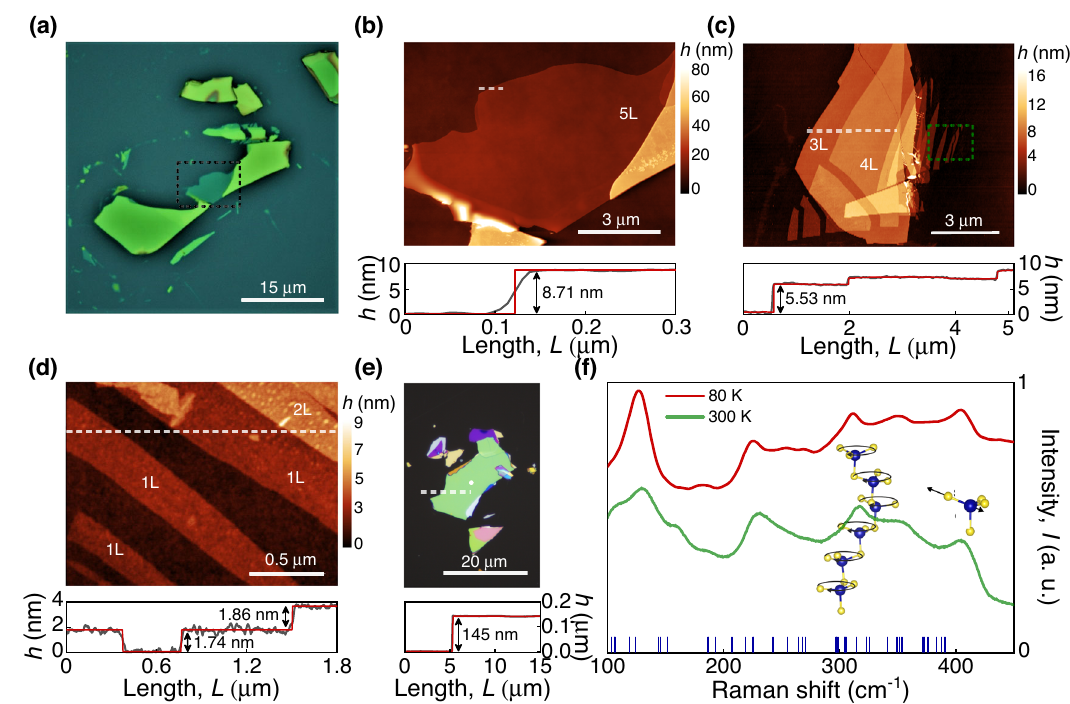
Fig. 2 Cleavage feasibility of non-van der Waals InGaS 3 . a 100X optical micrograph of a typical nanosheet on Si/SiO 2 substrate. b AFM topographical scan over the region marked by dashed rectangle in panel ( a ). Height pro fi le is taken along the dashed line in the map, showing the thickness equivalent to 5 L (8.71 ± 0.38 nm). c Same as in panel ( b ), but for thinner atomic sheets, with a thickness equivalent to 3 L (5.53 ± 0.32 nm) and 4 L (7.3 ± 0.34 nm). d Same as in panel ( c ), but for a magni fi ed region marked by the dashed rectangle in panel ( c ) showing atomic strips with thicknesses equivalent to 1 L (1.74 ± 0.24 nm) and 2 L (1.74 + 1.86 ± 0.28 nm). e 100X optical micrograph of a typical nanosheet on a quartz substrate. White dot marks the Raman spectra collection point (145 ± 4 nm). f Raman spectra of the nanosheet presented in panel ( e ) at room (green line) and liquid nitrogen (red line) temperatures. Vertical bars label evaluated Raman-active modes (see Supplementary Table 3 for details). Insets: Schematic representation of lattice vibration directions of the corresponding Raman-active